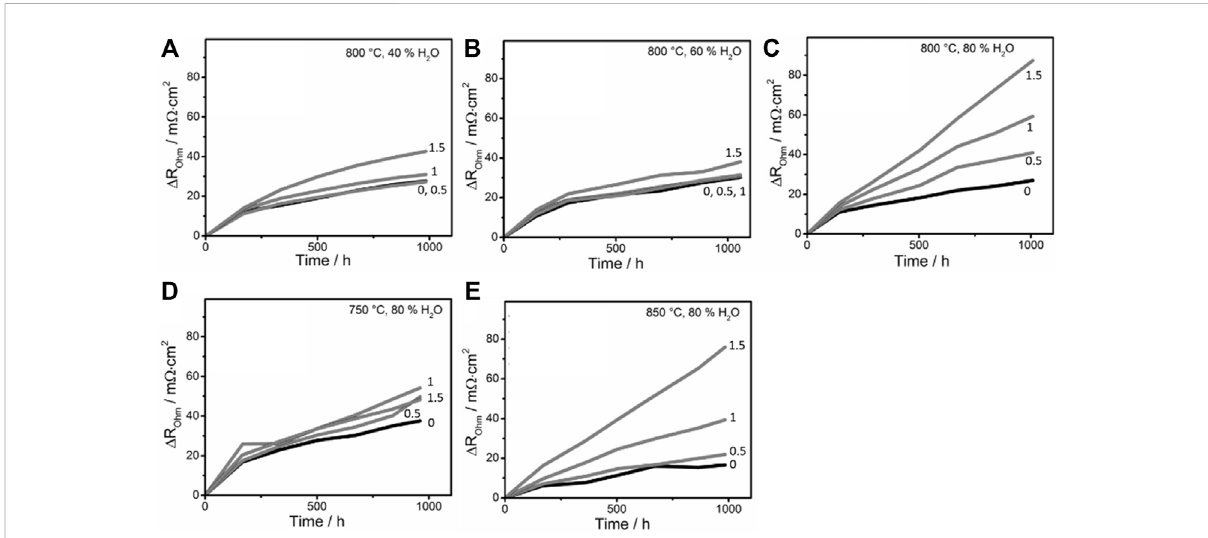
FIGURE 1 Temporal change of ohmic resistance of SOECs at different current densities from 0 to 1.5 A/cm 2 and (A) 800 ° C and 40% fuel humidity, (B) 800 ° C and 60% fuel humidity, (C) 800 ° C and 80% fuel humidity, (D) 750 ° C and 80% fuel humidity, and (E) 850 ° C and 80% fuel humidity measured by Hoerlein et al. (2018) The y-axis, Δ R ohm , is the ohmic resistance increase from the initial ohmic resistance of SOECs. Figure reused with permission from (Naeini et al., 2022).